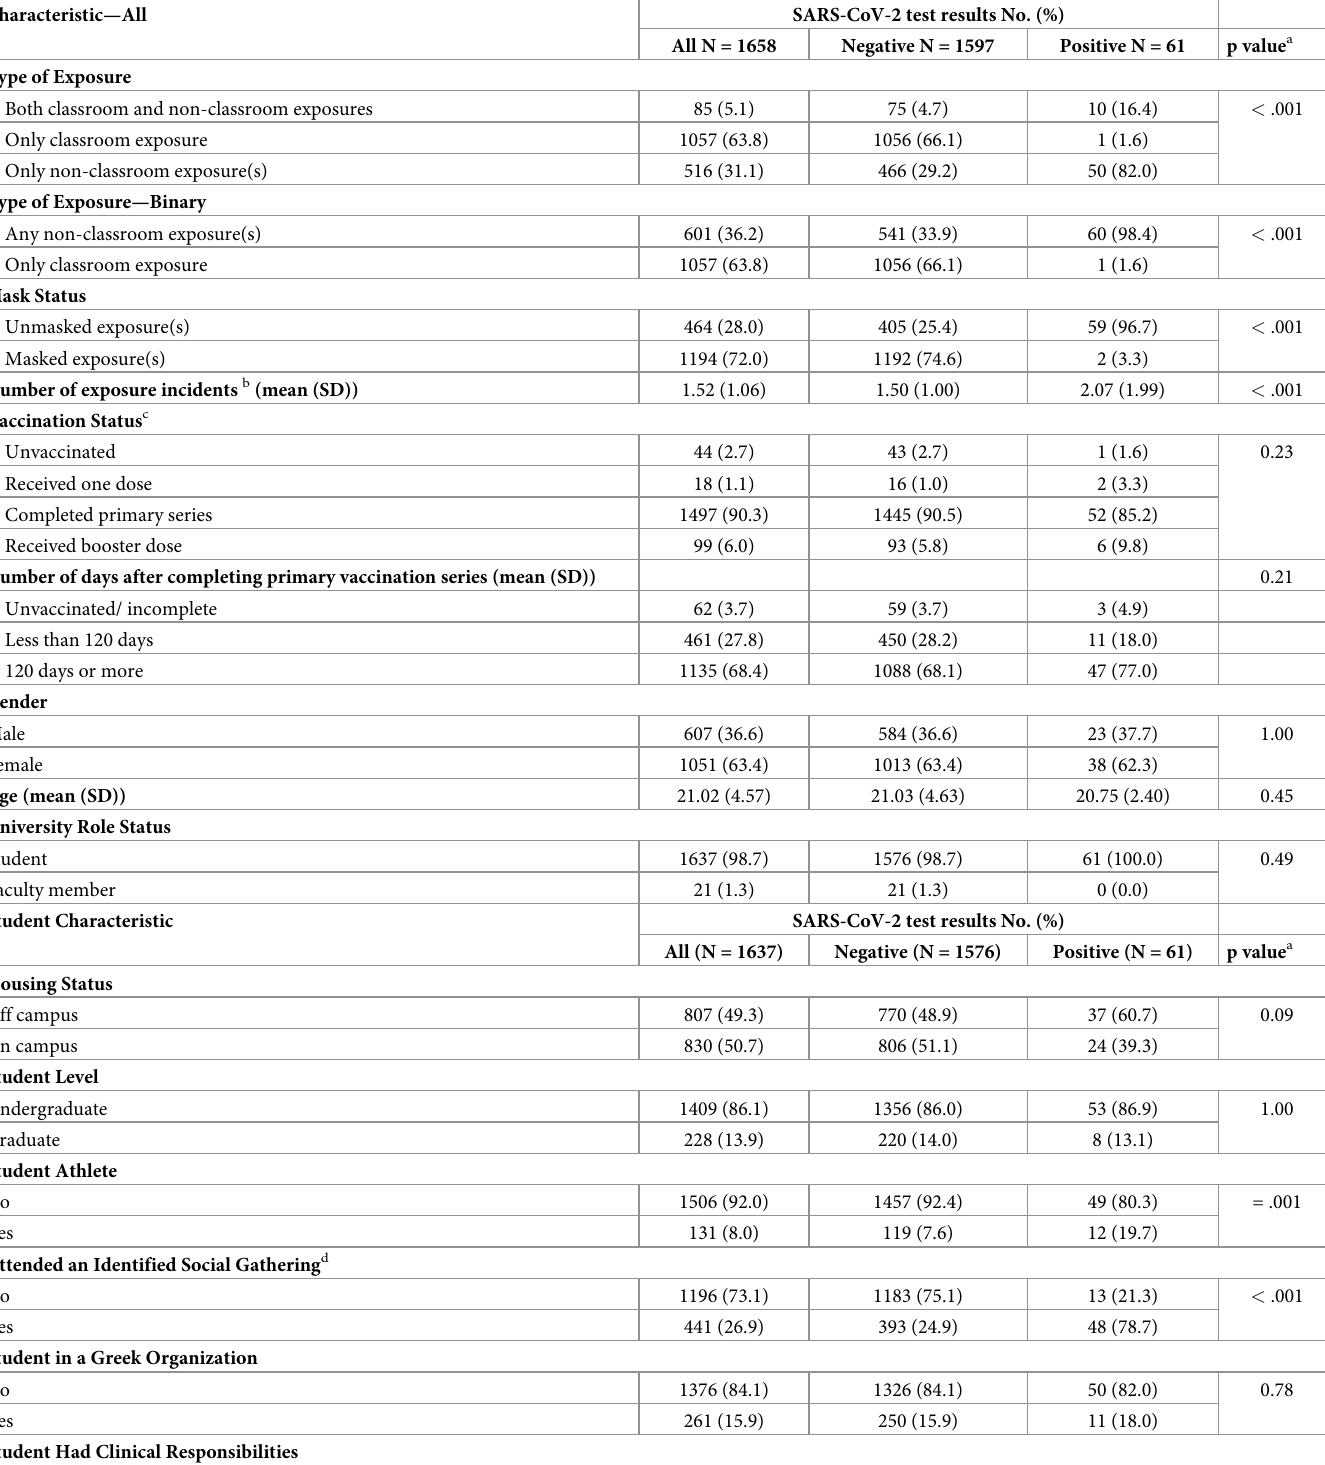
Table 1. Close contacts’ demographic characteristics, mask use, classroom exposure, and number of exposure incidents by SARS-CoV-2 test results.